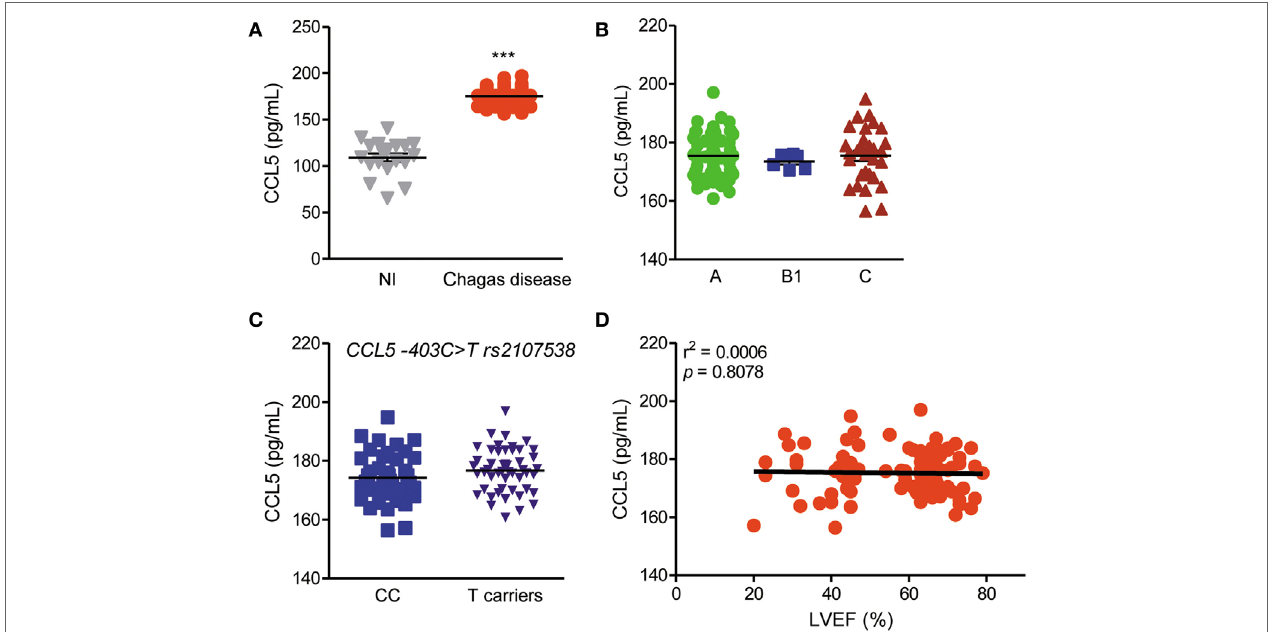
FigUre 1 | CCL5 levels and association with disease severity, genotypes and left ventricular ejection fraction (LVEF) in T. cruzi -infected patients. (a) CCL5 levels in the serum of seronegative noninfected (NI) individuals and individuals who were seropositive for Chagas disease (CD); *** P < 0.001 (Student’s t -test). (B) CCL5 concentrations in the serum of CD patients grouped as A (asymptomatic), B1 [mild chronic chagasic cardiomyopathy (CCC)], or C (severe CCC) (analysis of variance, Bonferroni posttest). (c) Comparison of CCL5 serum levels according to the absence (CC) or presence of rs2107538 allele T (Mann–Whitney test). (D) Correlation between the CCL5 serum concentrations and LVEF in patients; P = 0.8078, r 2 = 0.0006 (linear